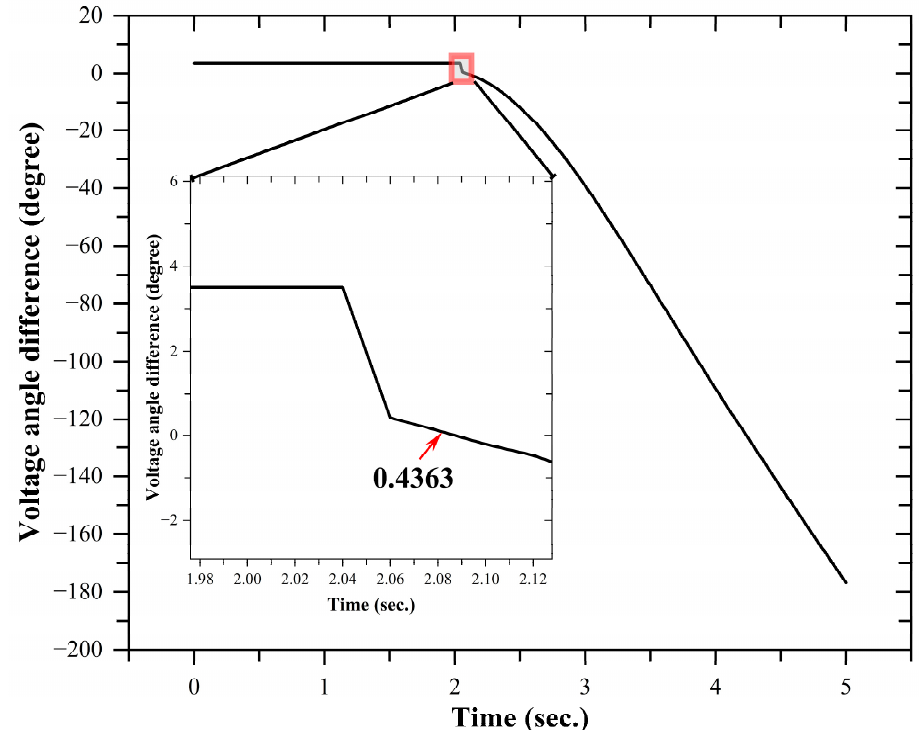
Figure 11. Proposed unintentional island threshold technique for under frequency Scenario 3.